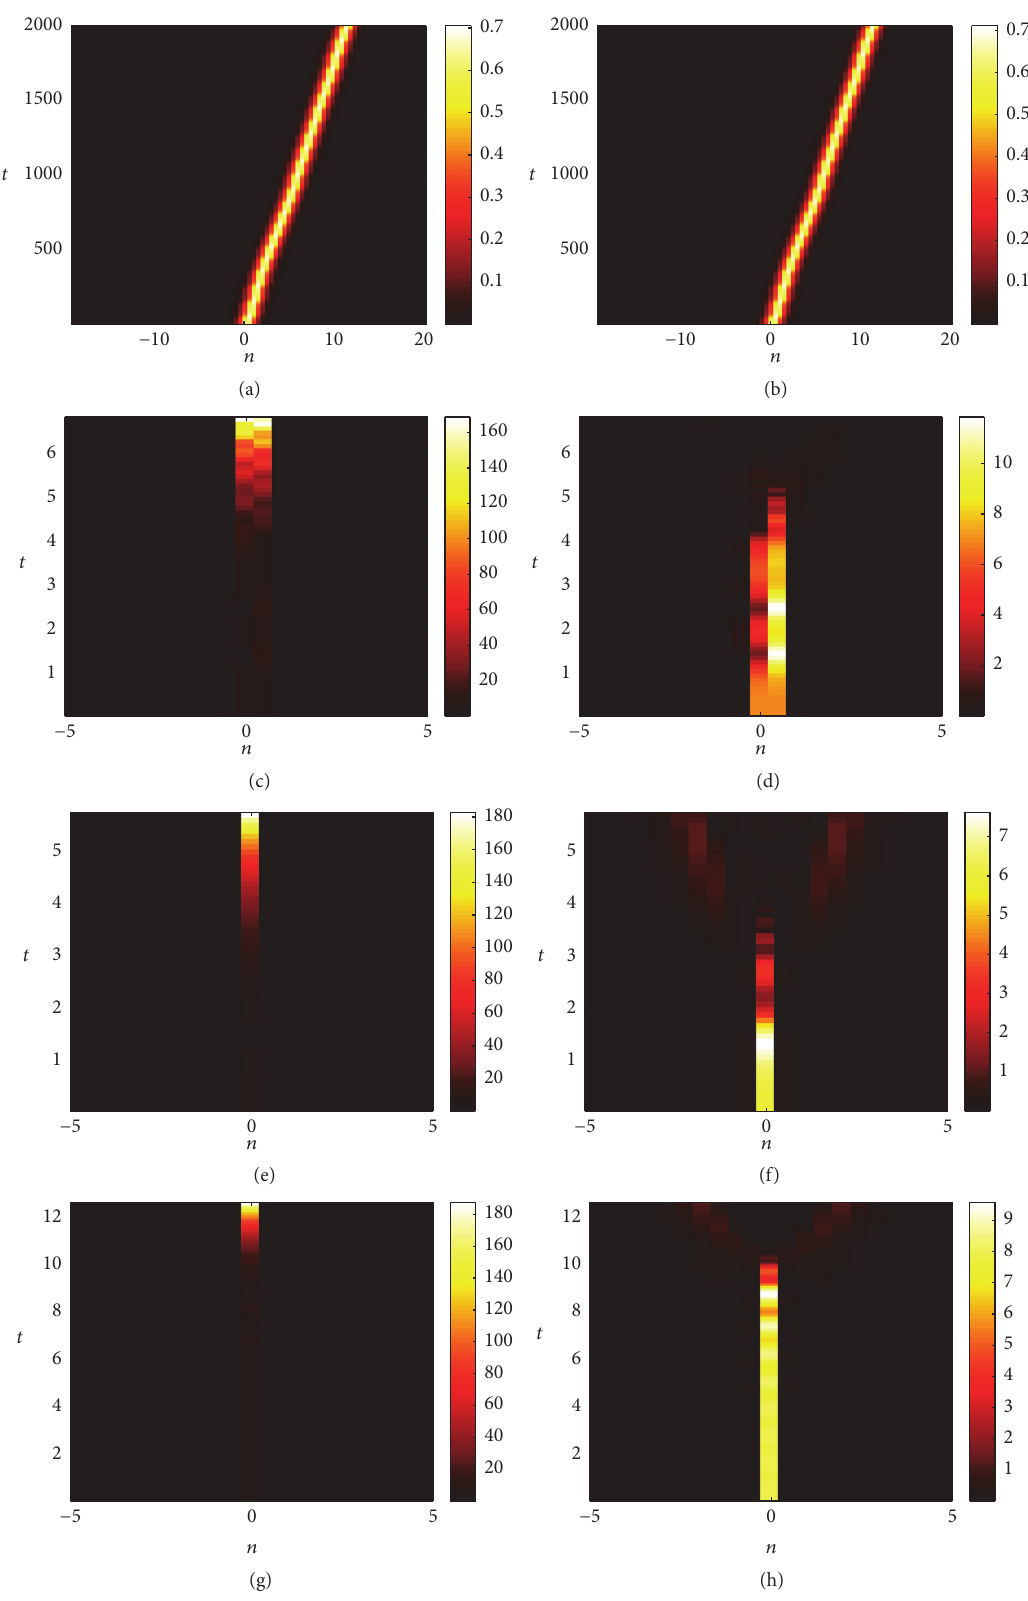
Figure 7: The typical dynamics of the instability of the discrete solitons in the previous figures. Here, 𝛾 = 0.5 and 𝜖 = 1 . Depicted in (a–h) are |𝑢 𝑛 | 2 and | V 𝑛 | 2 , respectively. (a–h) The dynamics of intersite soliton I with 𝜔 = 1.2 , intersite soliton II with 𝜔 = 5.2 , and onsite solitons I and II both with 𝜔 = 5.2